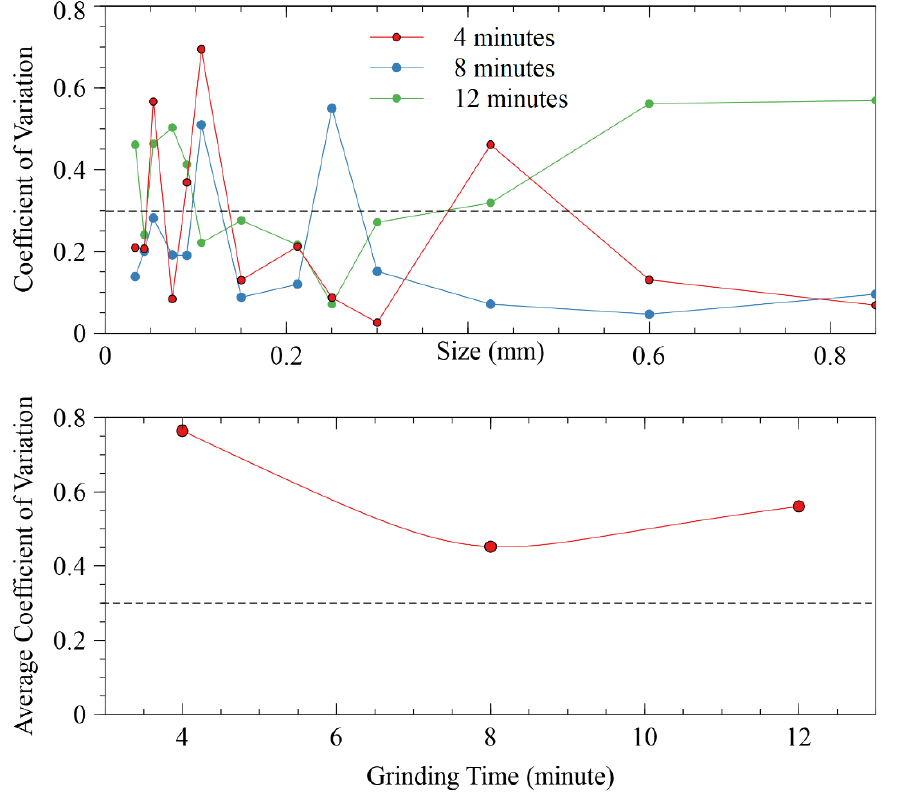
Figure 15. Coefficient of variation for LGP-1 for ore-A: ( above ) weight of each sizer, and ( bottom ) average of 𝐶𝑣 for each grinding time.